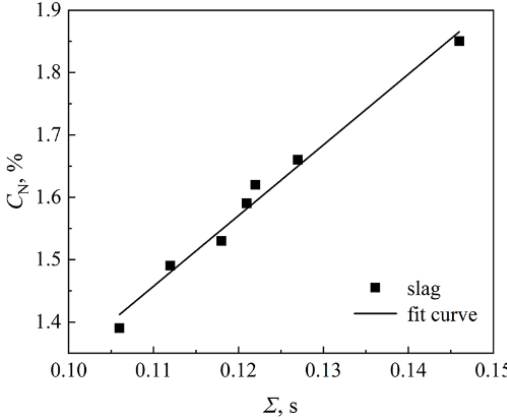
Figure 6. Relationship between nitrogen capacity and foaming index.